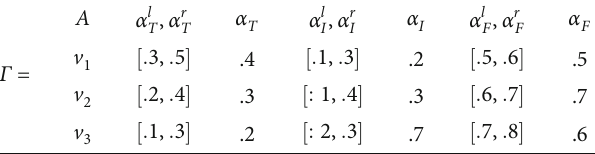
Figure 2: Represents a regular and totally regular neutrosophic cubic graph. Table 2: A neutrosophic cubic membership for vertices.